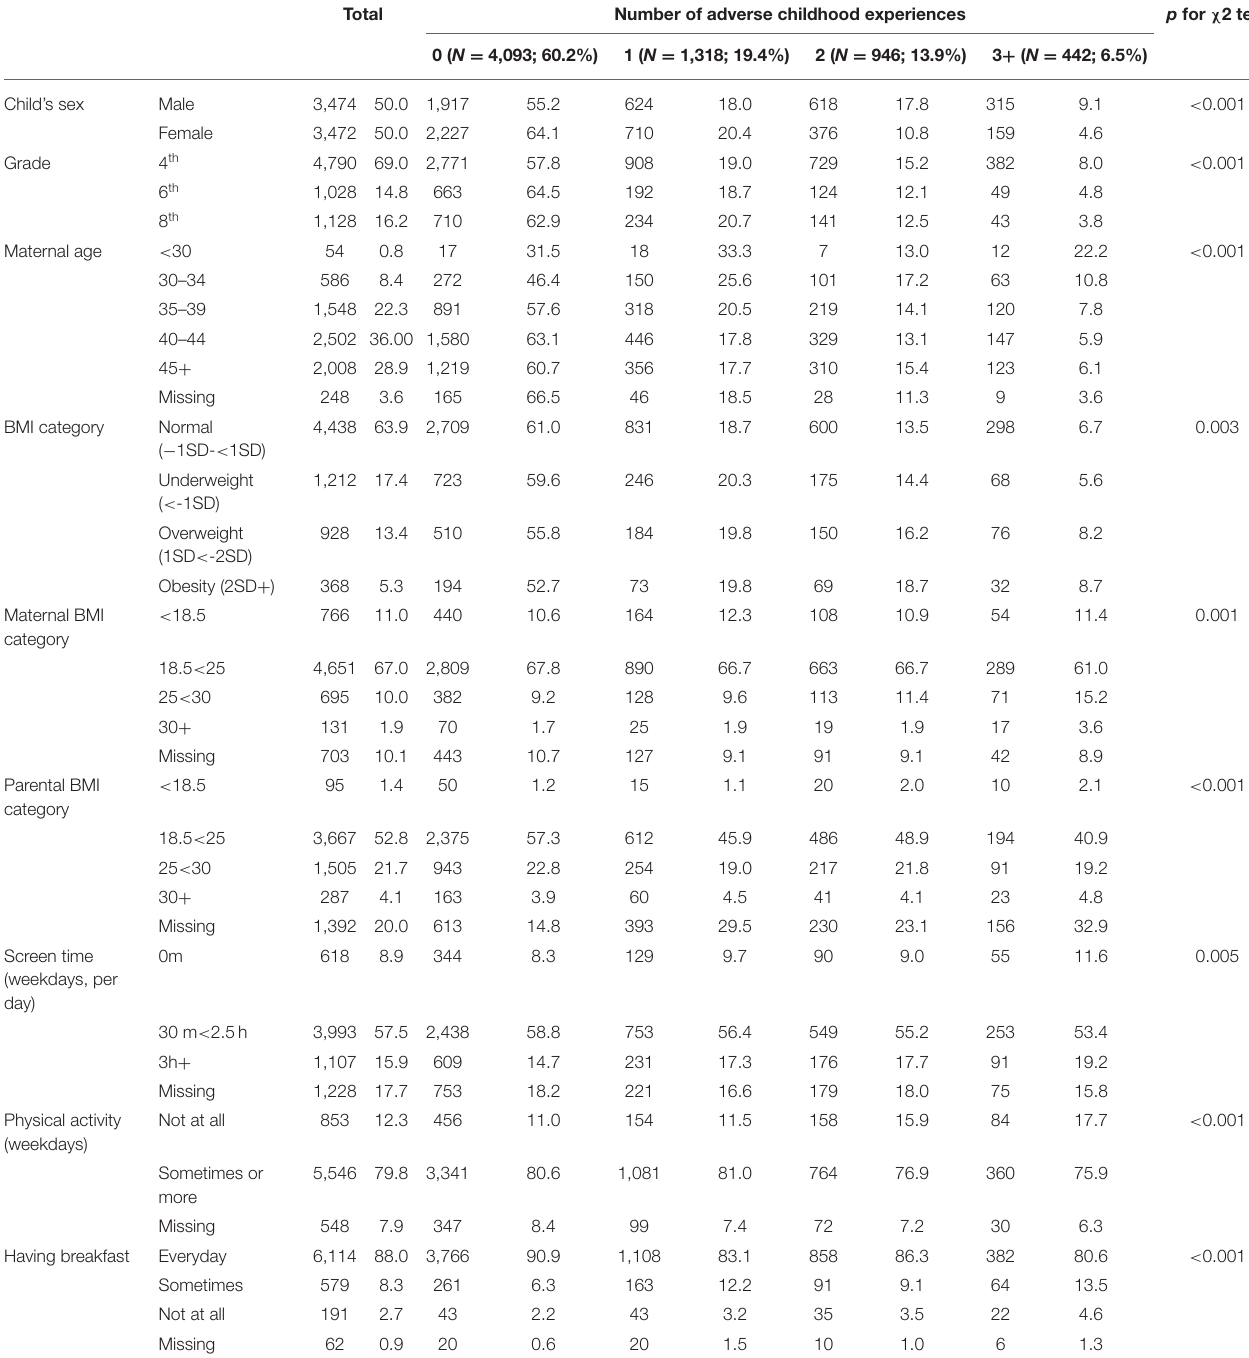
TABLE 1 | Characteristics of the sample ( N =